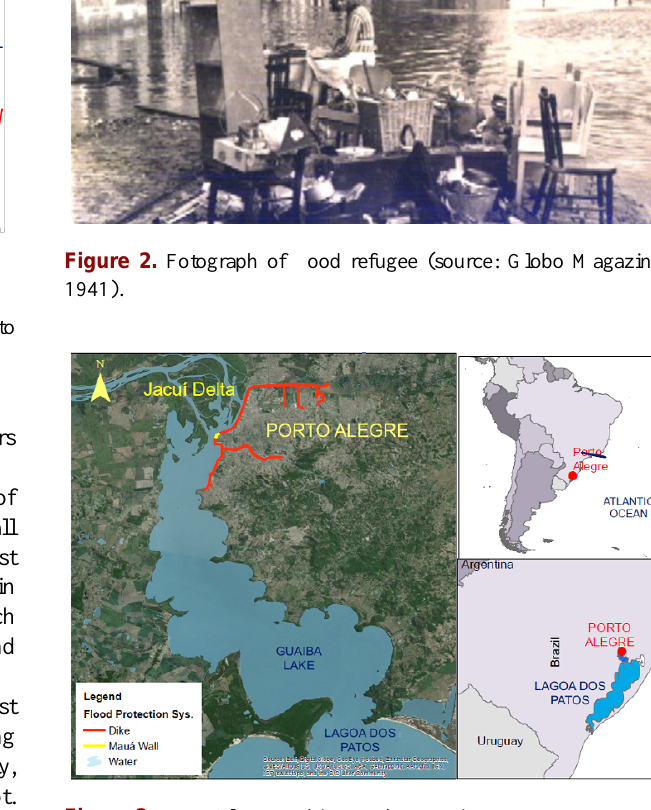
Figure 3. Porto Alegre and its flood protection